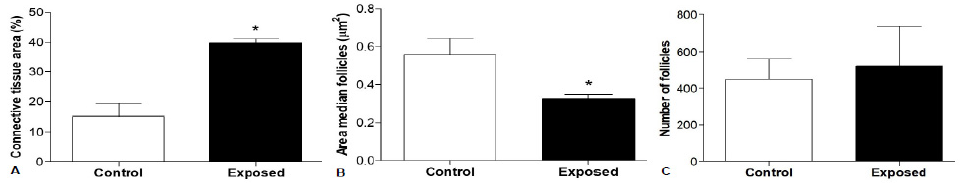
Figure 2. Histomorphometric analysis of Anguilla anguilla ovaries. ( A ) Percentage of connective tissue relative to gonad area; in the exposed eels, connective tissue occupied a larger area in the gonads than the control animals. ( B ) Mean area of follicles; follicles in the gonads from the exposed eels were smaller than those in the controls. ( C ) Number of follicles present within the gonads; no differences in the number of follicles were found between the exposed and control specimens. (*) Significantly different ( p < 0.05) from control values.